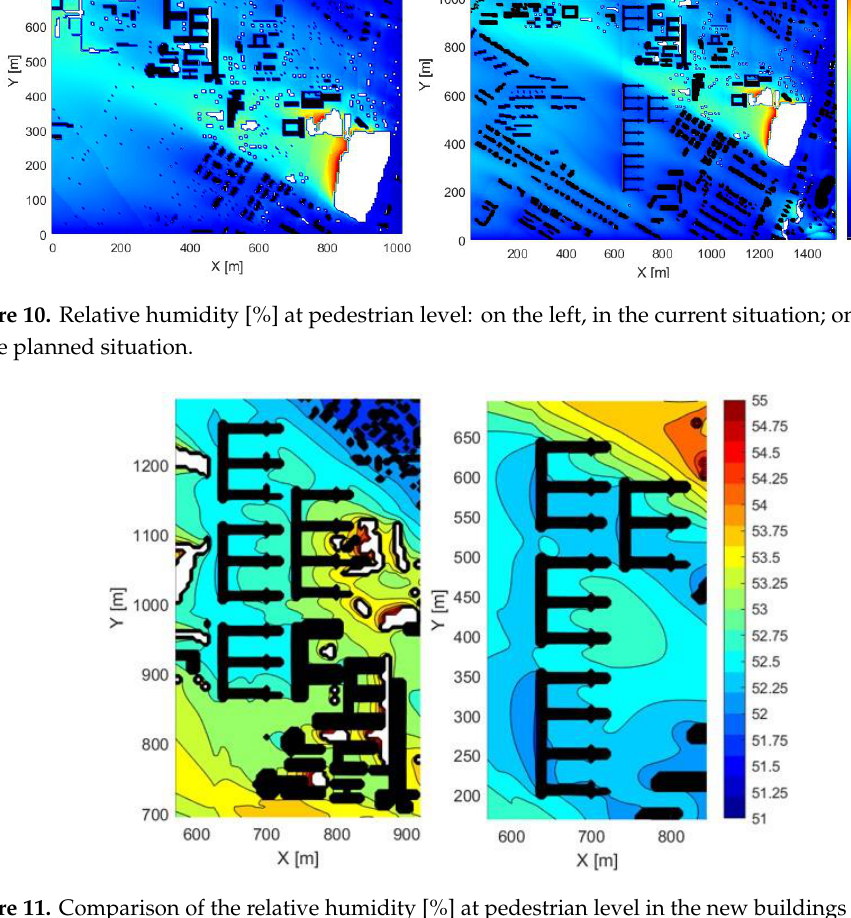
Figure 11. Comparison of the relative humidity [%] at pedestrian level in the new buildings and in the existing ones: on the left, the northern complex of proposed buildings with the old Campus; on the right, the southern complex of proposed buildings.